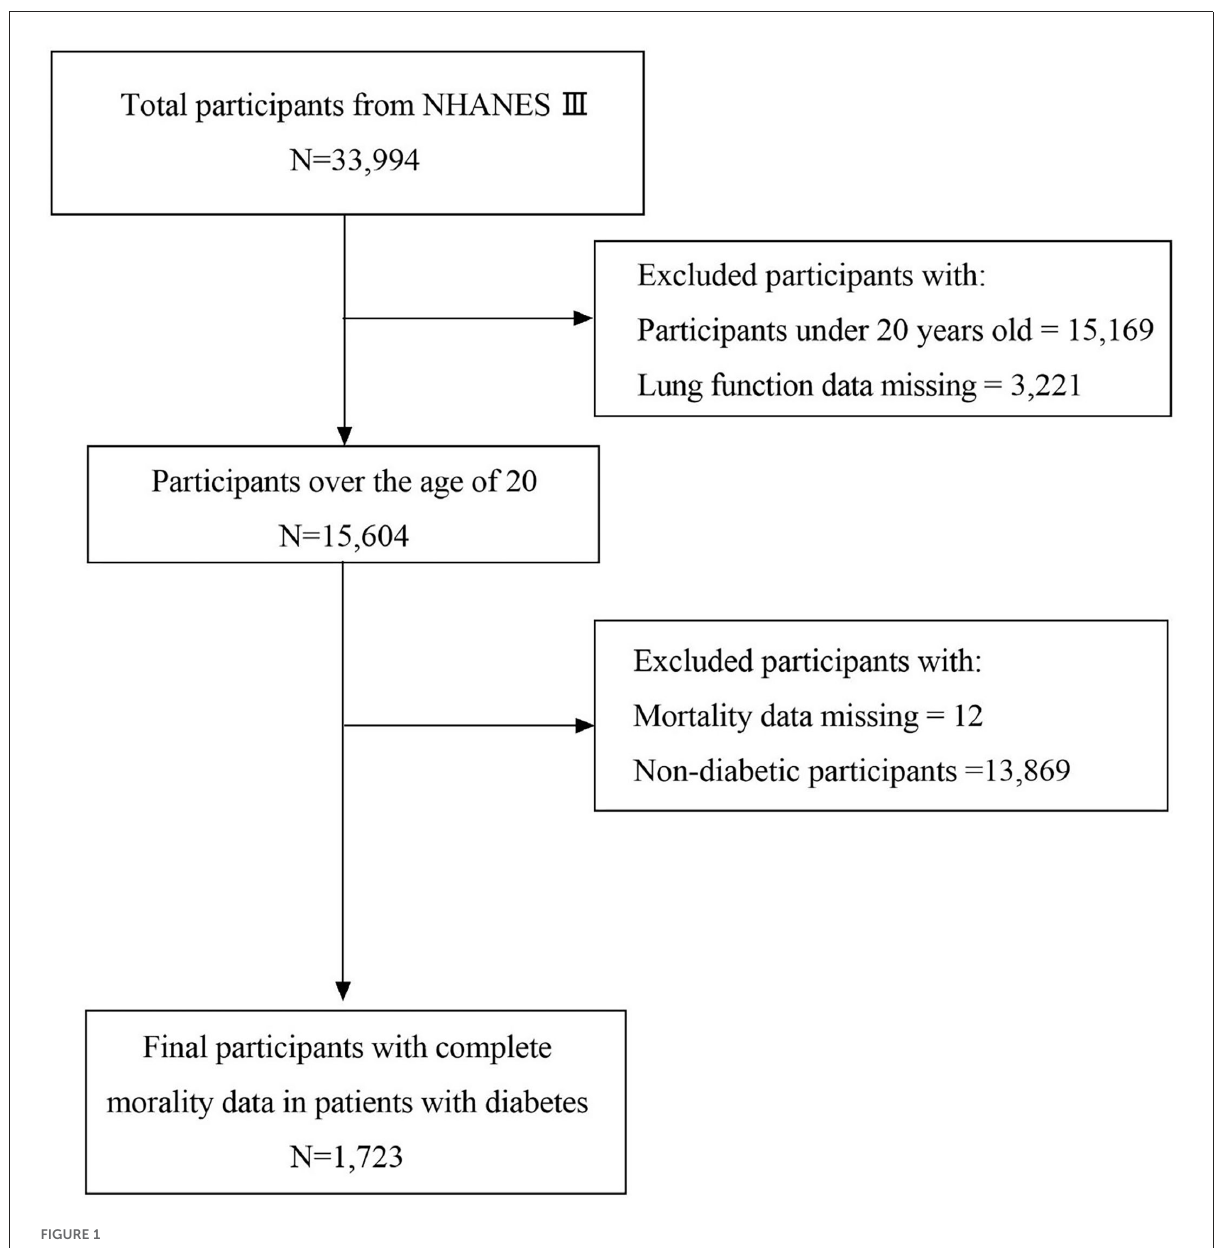
FIGURE1 Study participant